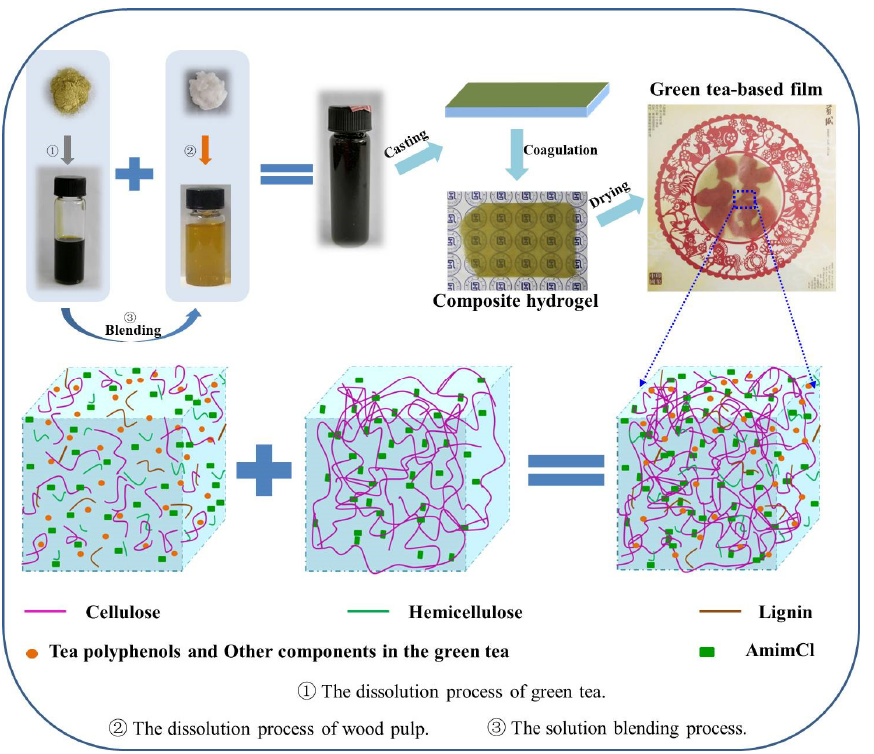
Figure 1. Schematic illustration of the fabrication process of green-tea-based all-biomass composite films.